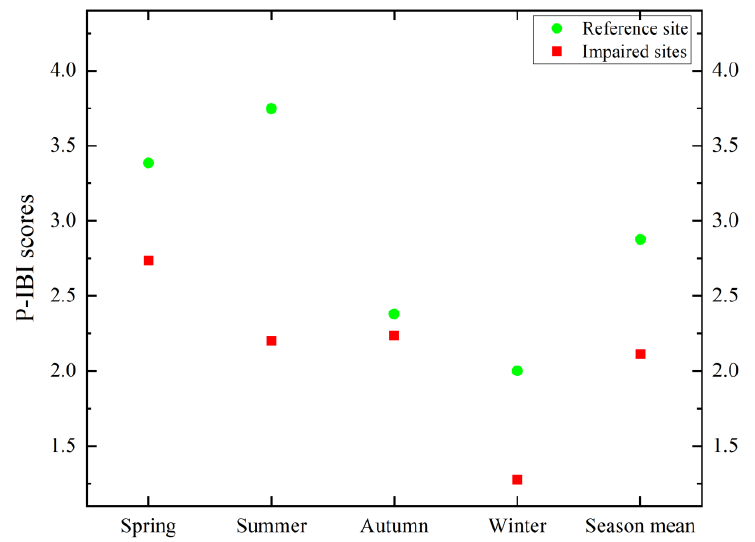
Figure 5. Separation ability test of the reference site and impaired sites in different seasons.